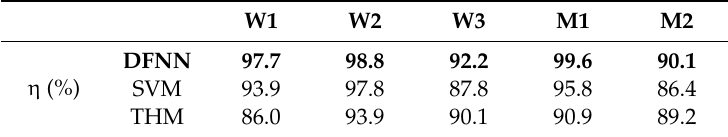
Table 3. Classification e ff ectiveness η results of selected methods for one-person training